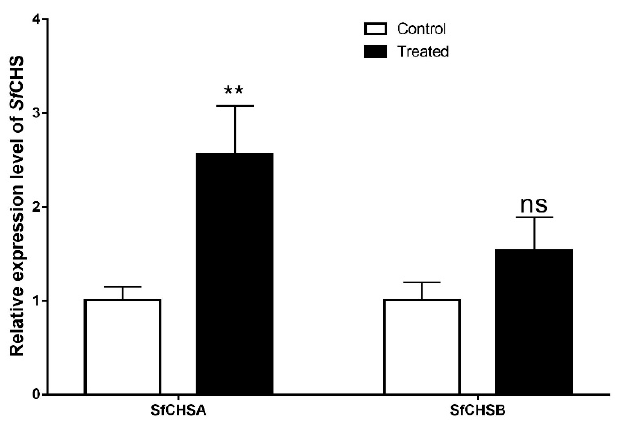
Figure 4. Relative expression levels of SfCHSA and SfCHSB after exposure to lufenuron. Note: ** on the column indicates a significant difference between the treatment group and the control group ( p < 0.01), ns means not significantly different ( p > 0.05).